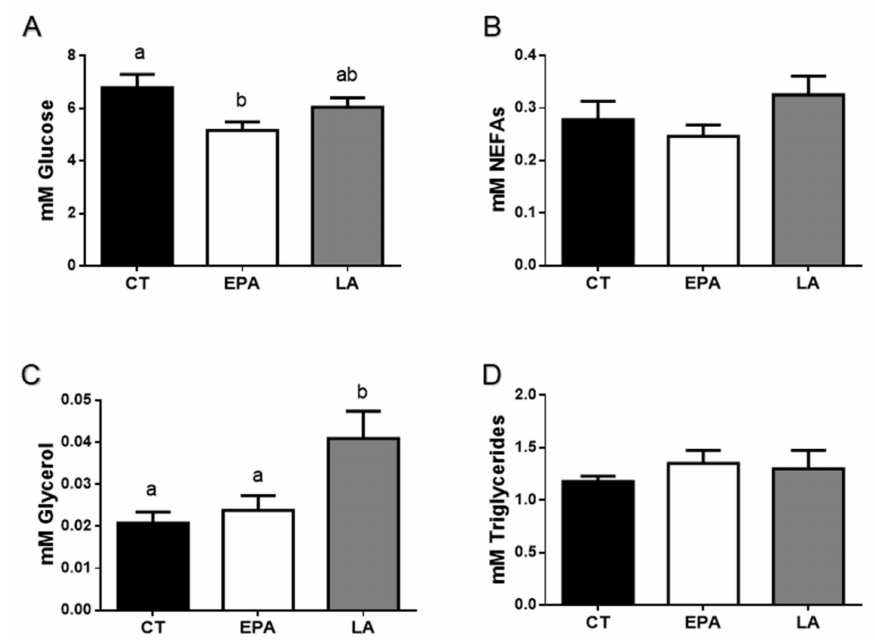
Figure 2. Rainbow trout ( A ) glucose, ( B ) NEFAs, ( C ) glycerol, and ( D ) triglyceride plasma levels in rainbow trout at 6 h after being force-fed with EPA, LA, or vehicle without fatty acid as control. Data are shown as mean + SEM ( n = 10). Significant di ff erences ( p < 0.05) among treatments are indicated by di ff erent letters (a,b). CT: control; EPA: eicosapentaenoic acid; LA: linoleic acid; NEFAs: non-esterified fatty